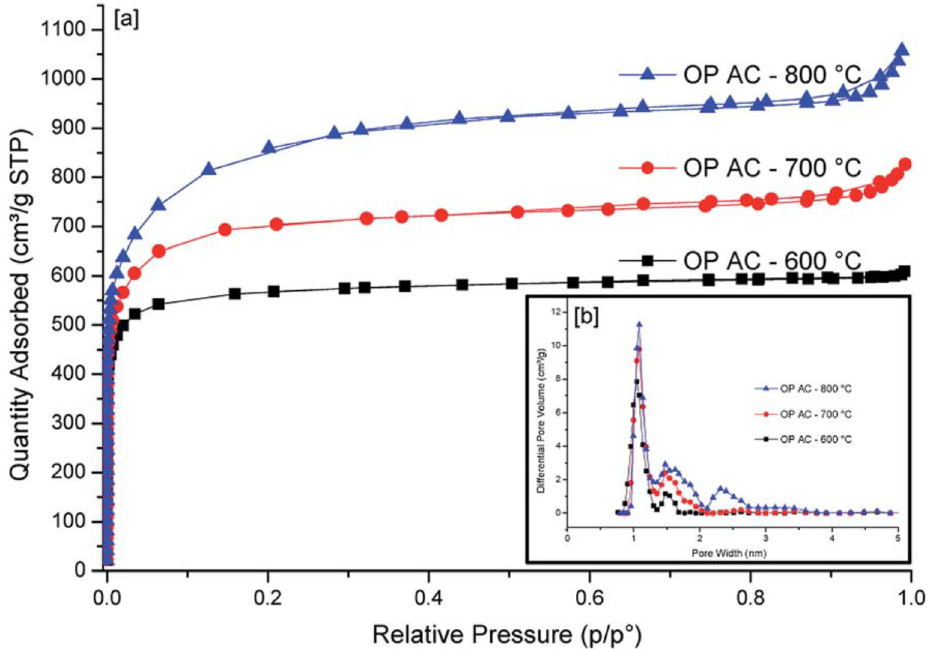
Figure 14. Nitrogen isothermal sorption results of the onion peel-derived activated carbons: ( a ) quantity of N 2 sorption, and ( b ) pore size distribution. Reprinted from [23], ©2020 The Authors.